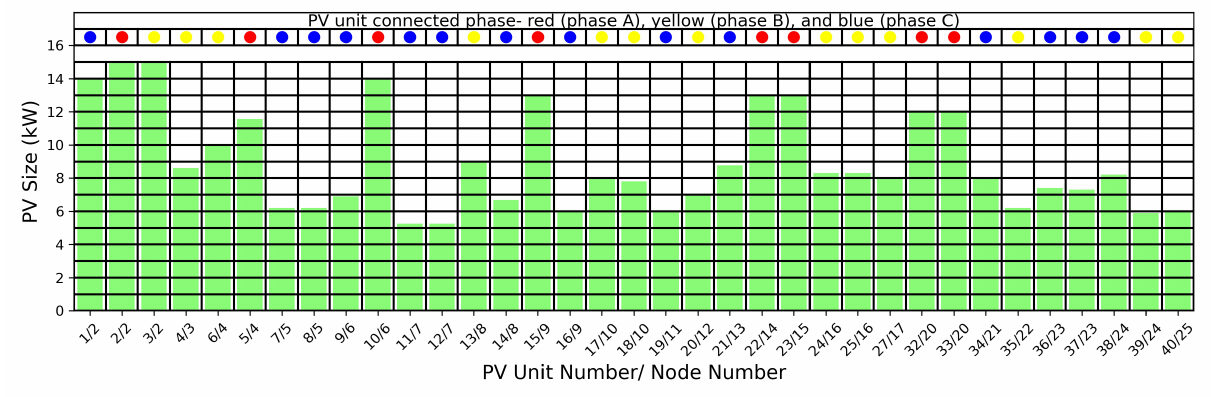
Figure 14. Optimized PV values with the DLR as the thermal limit and OLTC, RPC coordinated voltage regulation